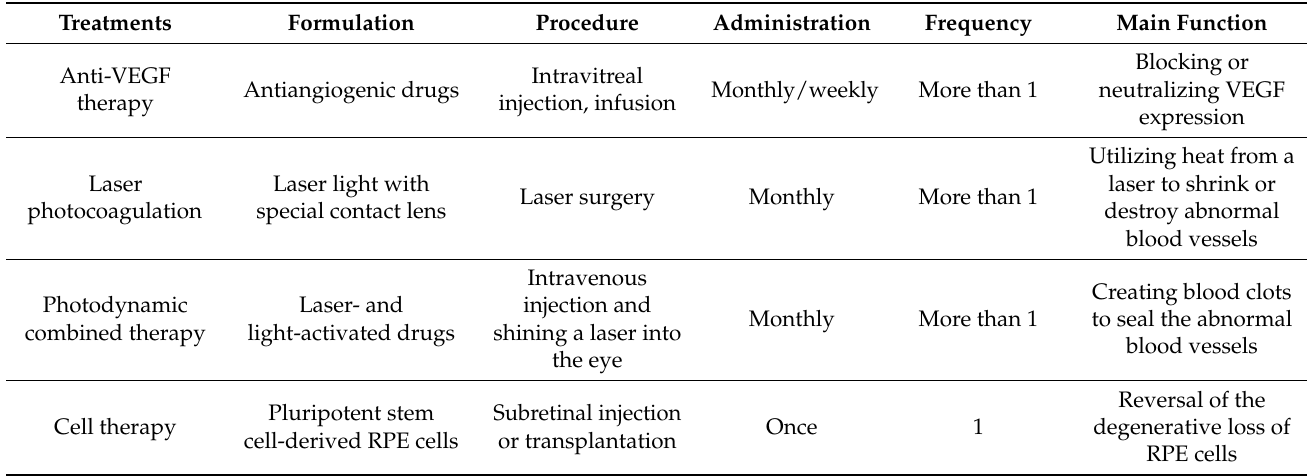
Table 1. Current Treatments for wet